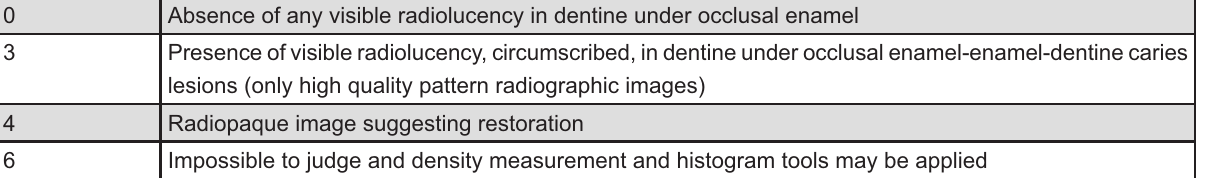
Impossible to judge and density measurement and histogram tools may be applied Figure 2- Weerheijm, Gruythuysen and Van Amerongen 19 (1992) criteria for radiographic examinations